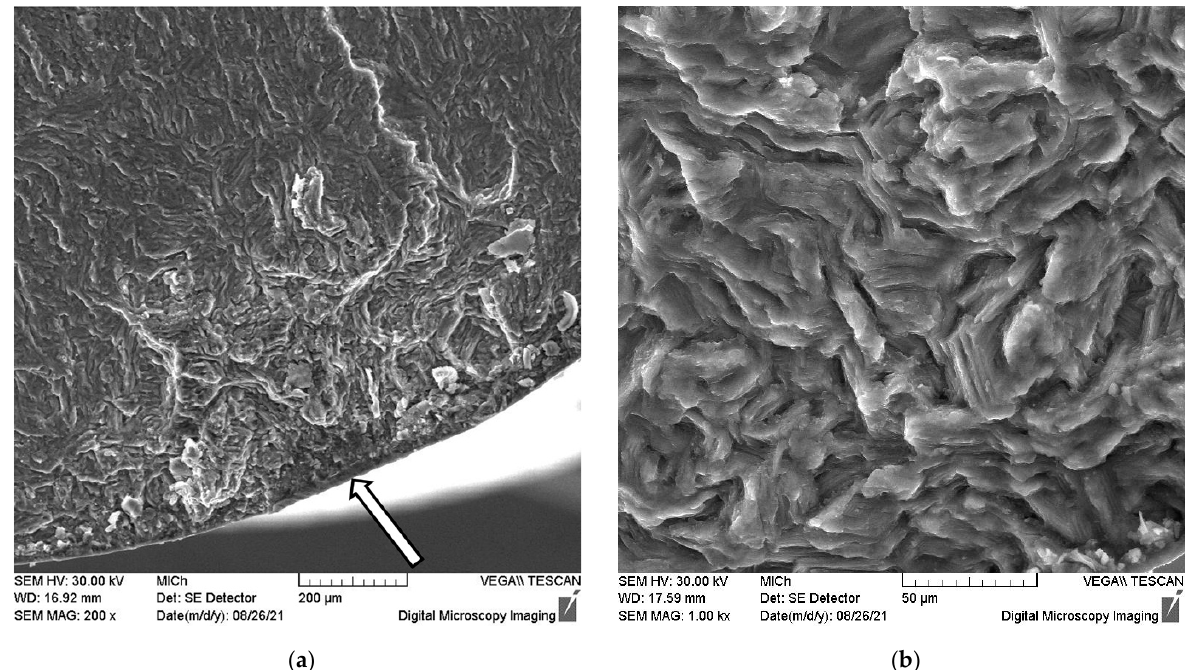
Figure 15. The initiation point of the fatigue crack ( a ) and the detail of the fatigue fracture surface close to the initiation point ( b ).